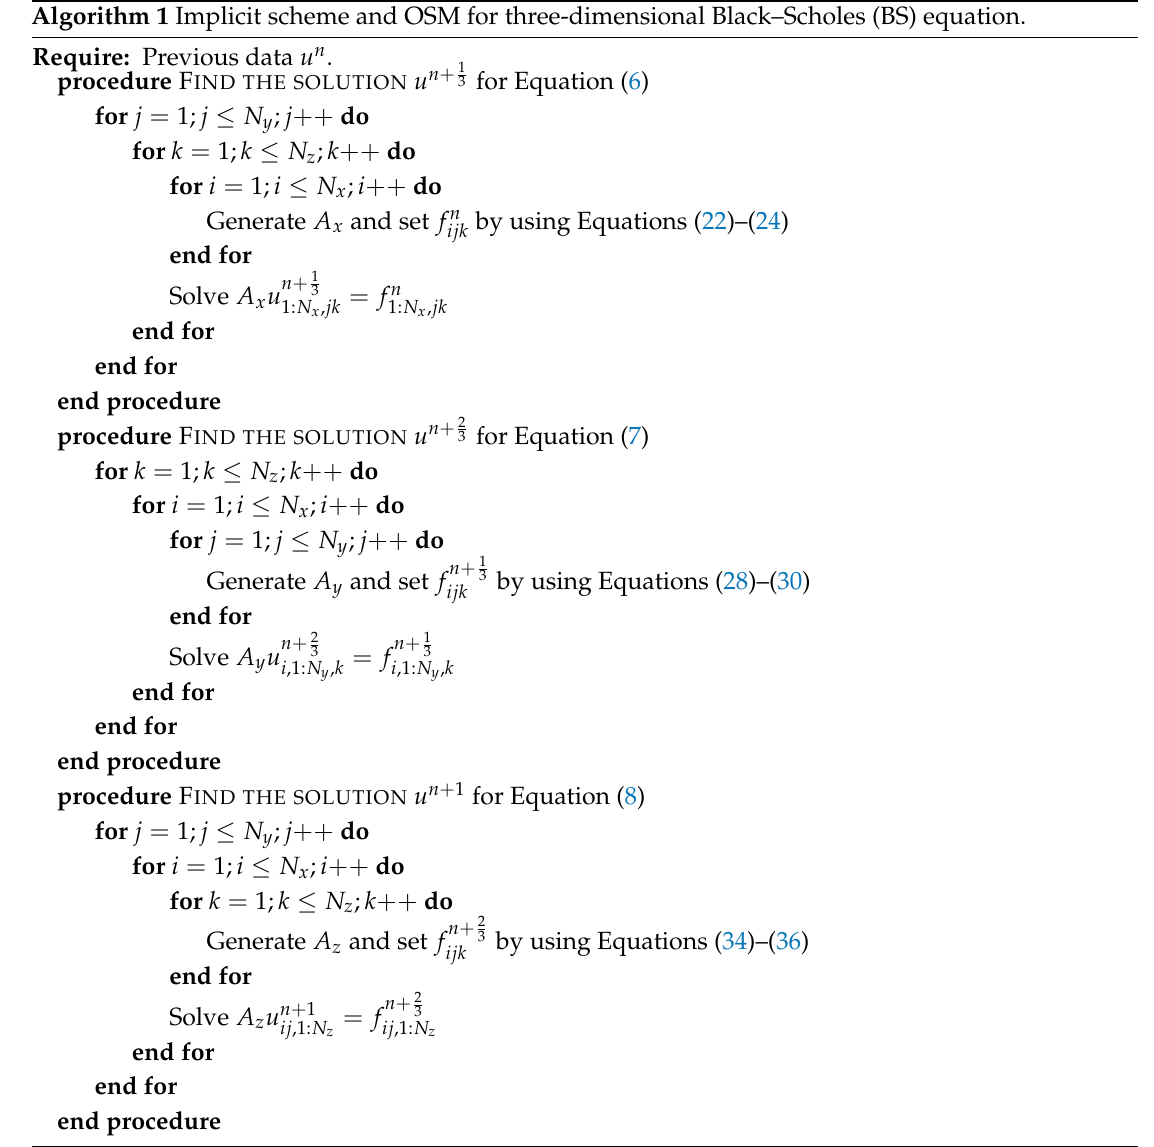
Algorithm 1 Implicit scheme and OSM for three-dimensional Black–Scholes (BS)